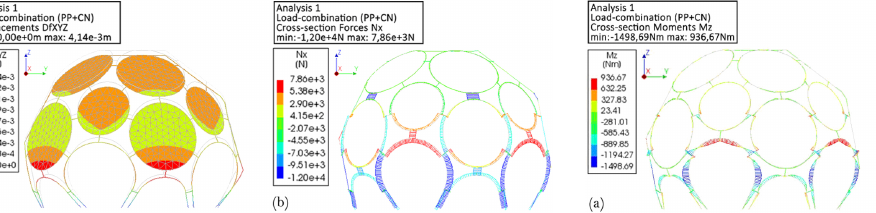
Figure 15: Self-weight and snow (Case 1): (a) Displacement diagram;